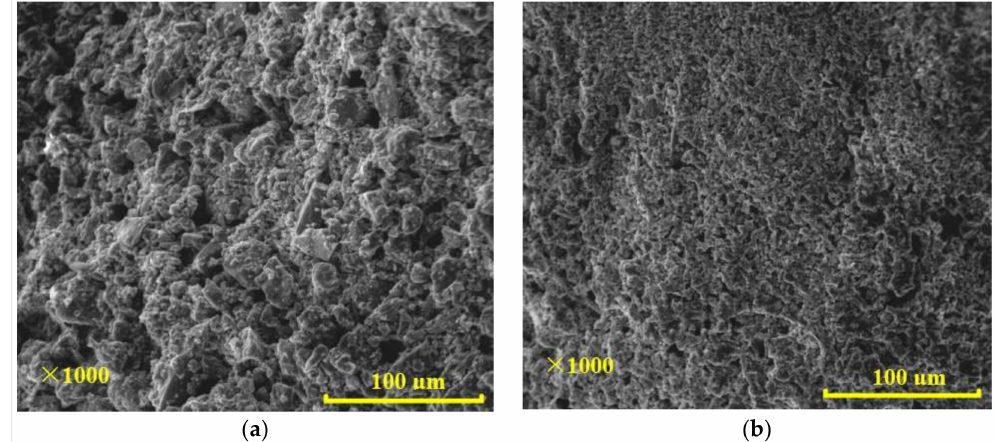
Figure 11. SEM pictures at a magnification of 1000 denoting the destructive effect of pumping agent on flocs: ( a ) CPB without pumping agent; ( b ) CPB with pumping